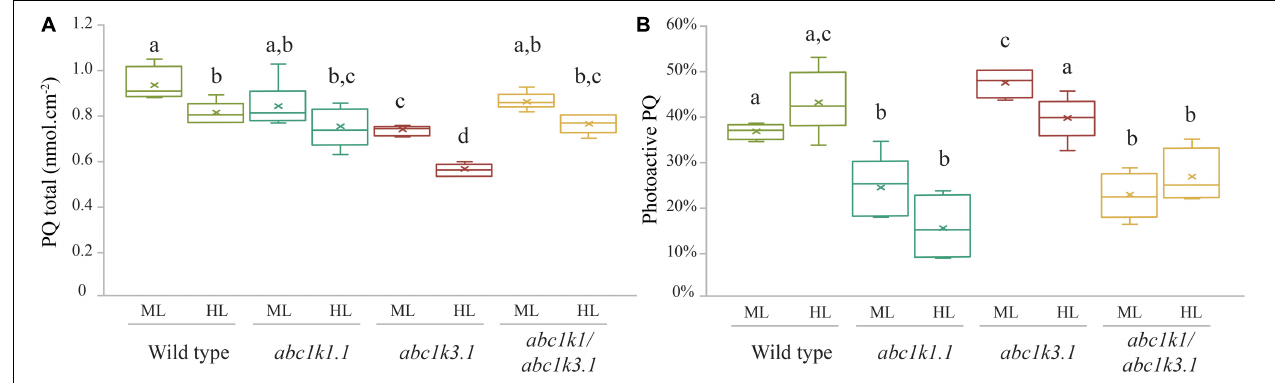
FIGURE 5 | Photoactive PQ pool is smaller in all the lines containing the abc1k1 mutation. (A) Total plastoquinone content (nmol cm − 2 ) and (B) photoactive plastoquinone pool (as% of total PQ) were analyzed from leaves of Wild type, abc1k1.1 , abc1k3.2, and abc1k1/abc1k3.2 under moderate light and after 3 h high light. The photoactive plastoquinone pool was determined by the difference of the plastoquinol (PQH 2 ) amount measured when the PQ pool is maximally reduced by strong white light pulse (15 s at 2,000 m − 2 s − 1 ), and the amount of PQH 2 measured when the PQ pool is fully oxidized after far-red illumination (2 min at 5.5 µ mol of photons m − 2 s − 1 ). Whiskers and box plot shows the minimum, first quartile, median, average, third quartile, and maximum of each data set ( n = 4 biologically independent samples). Superscript letters are used to indicate statistically different groups by paired Student’s t -test ( p <